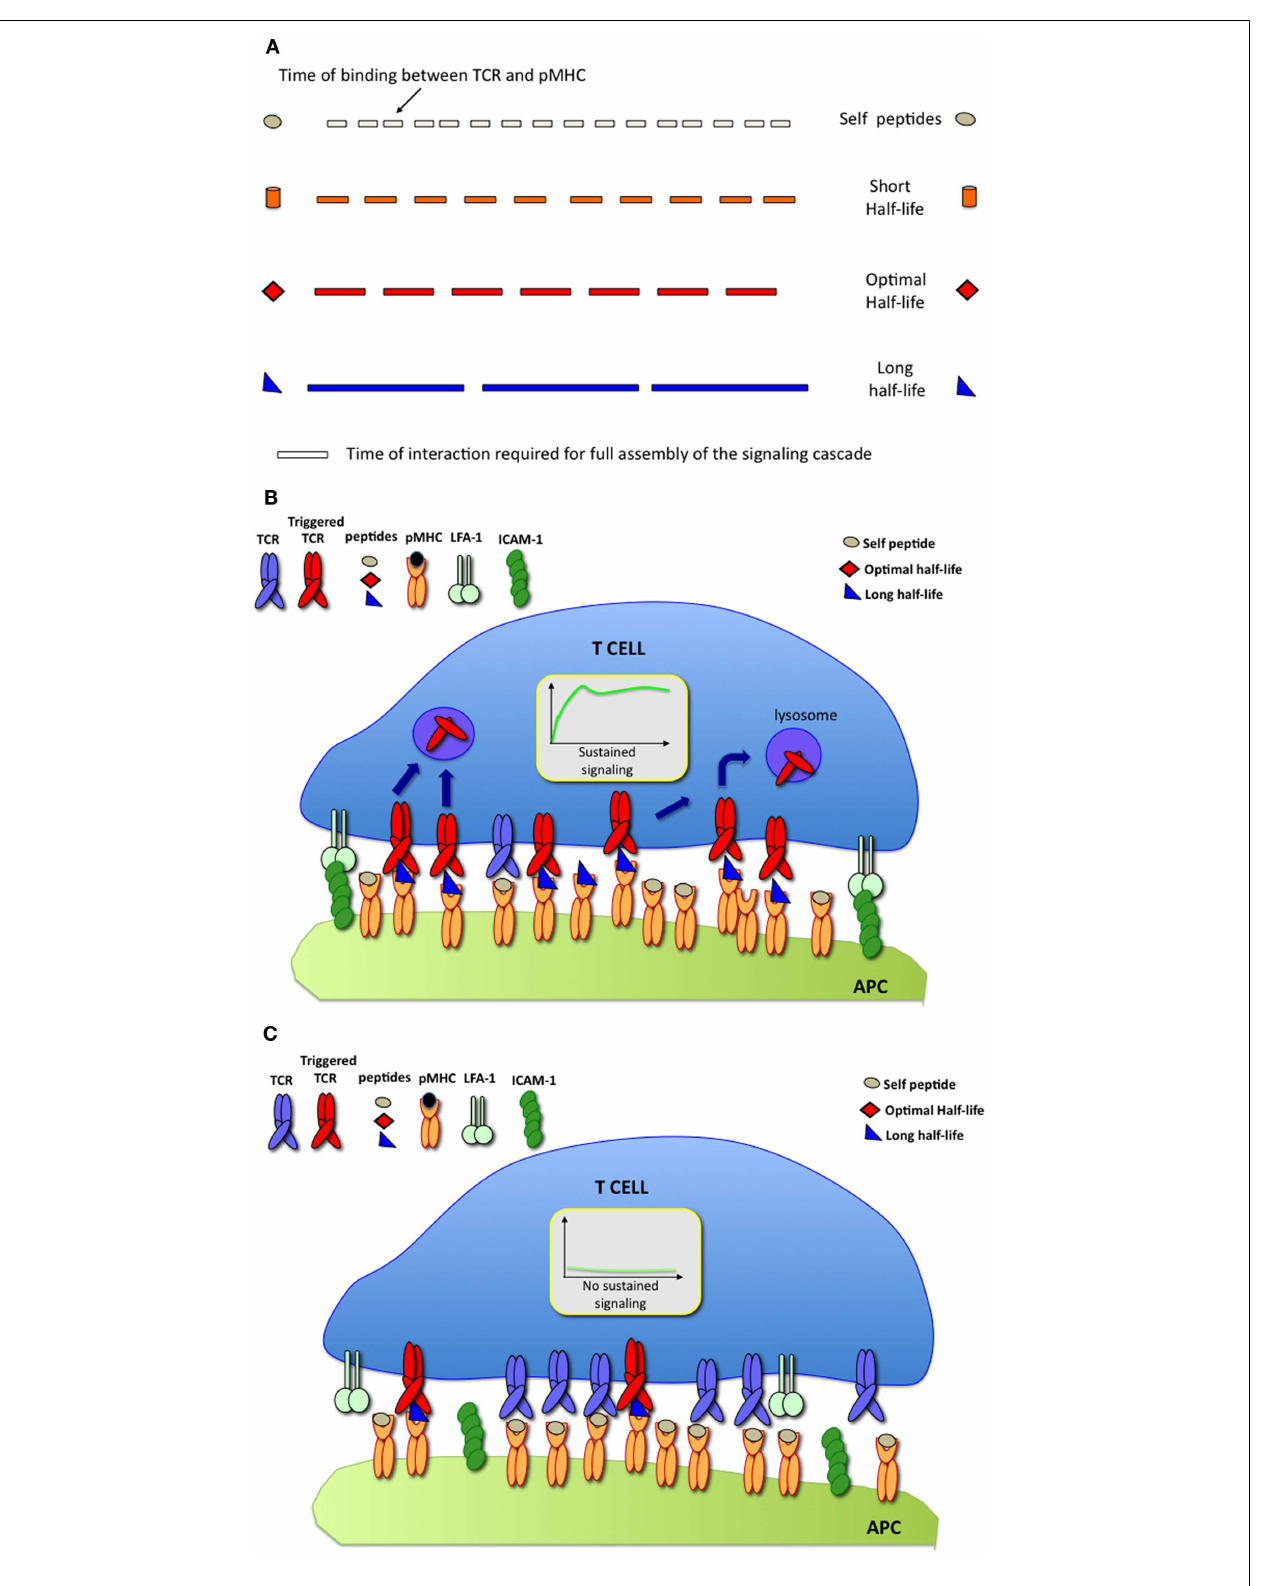
FIGURE 2 | (A) The serial engagement model postulates that pMHC ligands exhibiting optimal binding half-lives toTCR behave as optimal agonists; (B) At high pMHC densities, pMHC exhibiting long binding half-lives are stimulatory; (C) At low pMHC densities, pMHC exhibiting long binding half-lives fail to triggerT cell